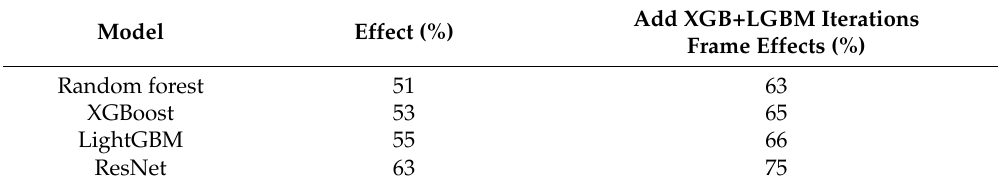
Table 5. Add XGB+LGBM iterative framework before and after the effect comparison.